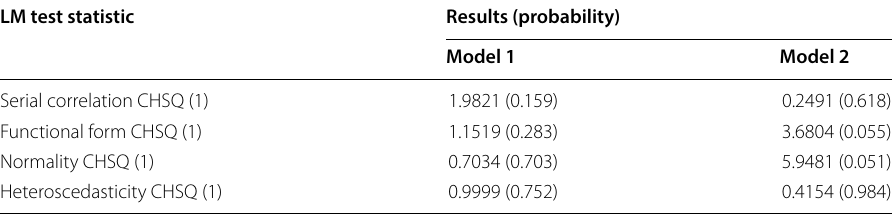
Table 4 Diagnostic Results for Models 1 and